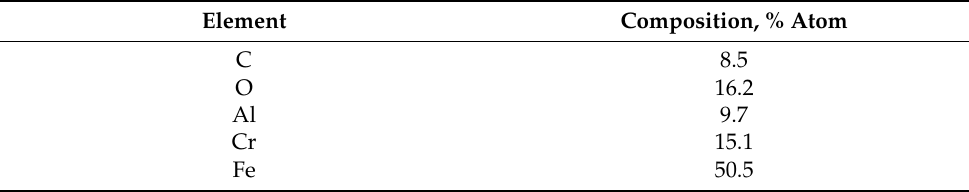
Table 1. Composition of the catalyst precursor based on energy-dispersive X-ray spectrum (EDX).